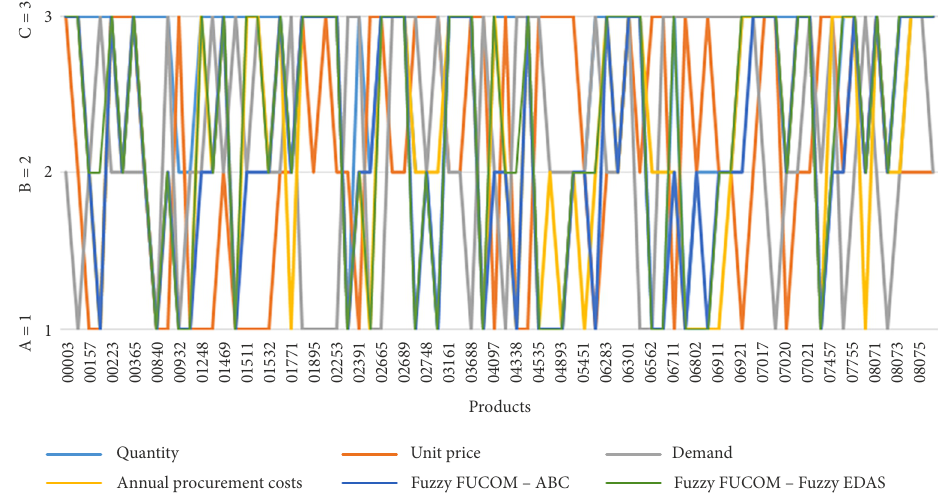
Figure 3. Comparative analysis of fuzzy FUCOM – fuzzy EDAS model with other approaches in terms of inventory